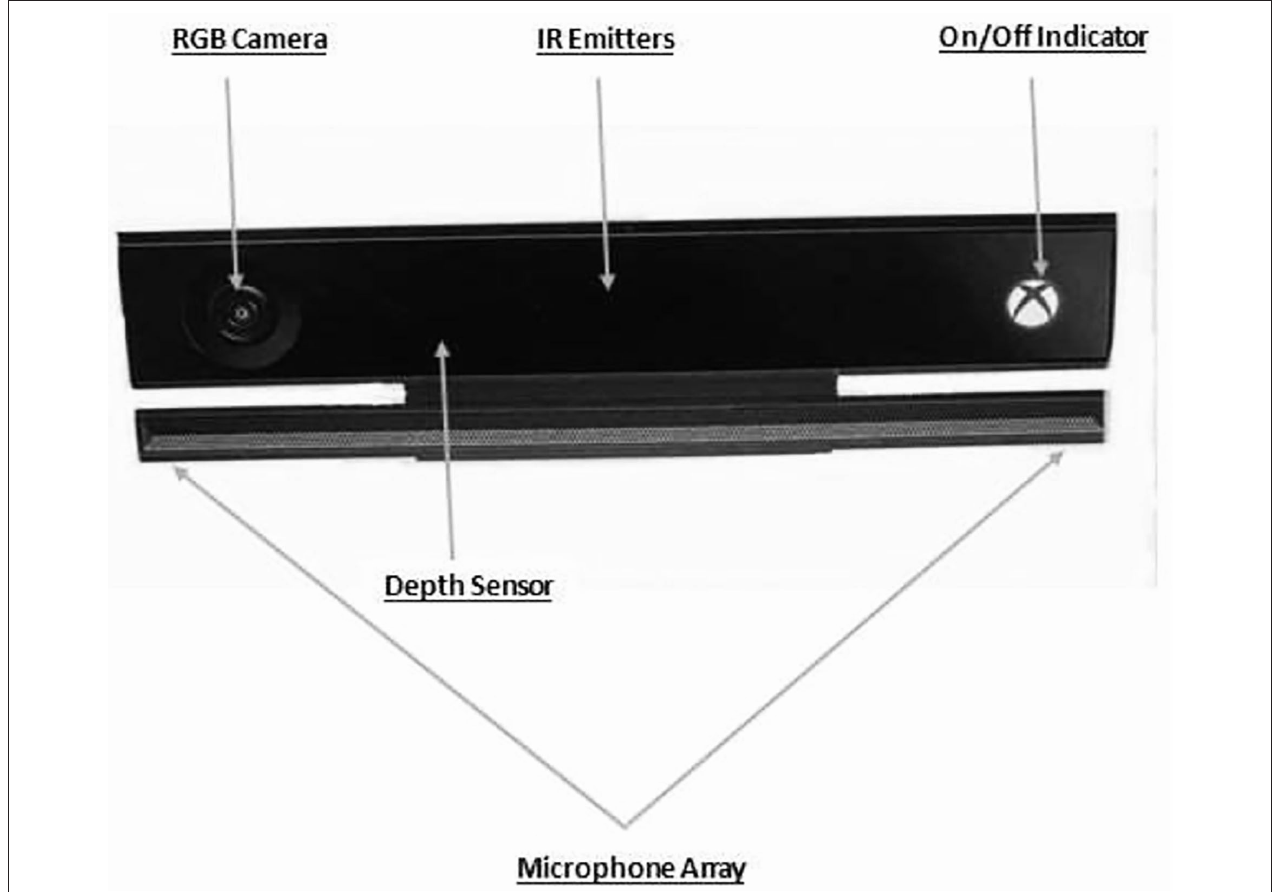
FIGURE 2 | Microsoft Kinect v2